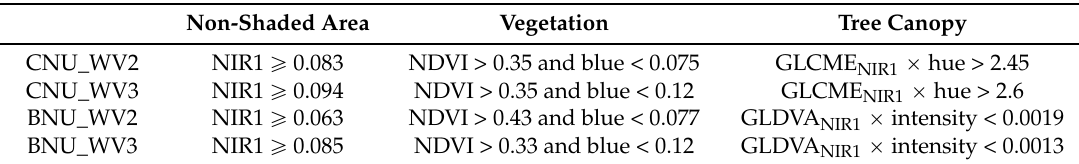
Table 4. Threshold values for hierarchical classification